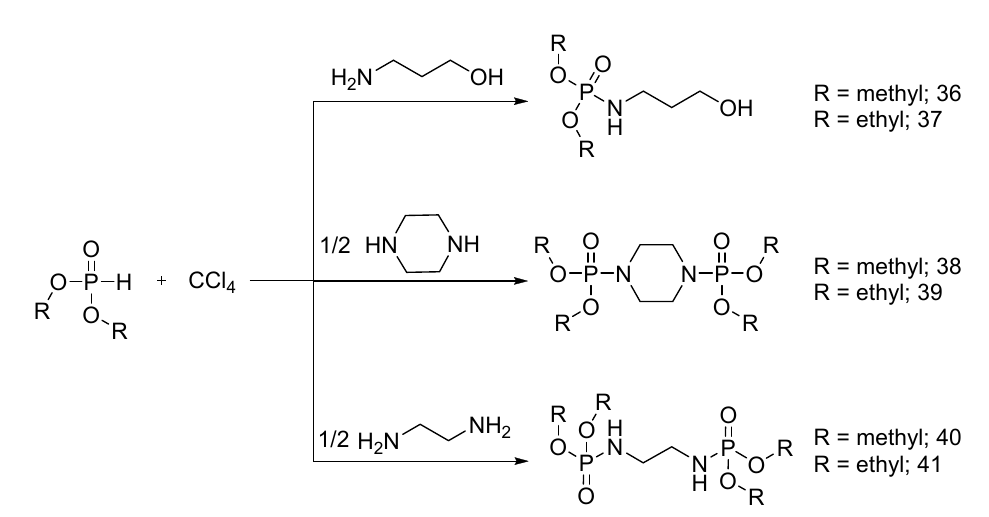
Figure 26. Scheme of the synthesis of phosphoramidate derivatives ( 36 )–( 41 ).